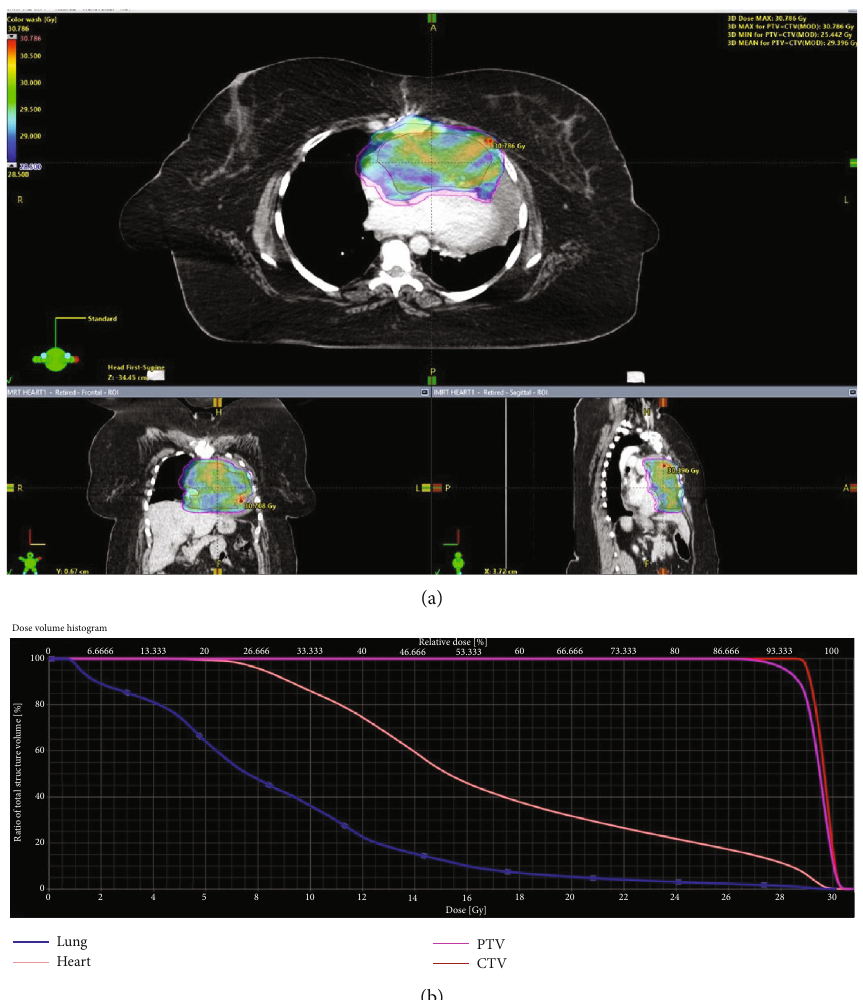
Figure 2: (a) IMRT radiation treatment plan and dose-volume histogram: clinical target volume (CTV) (red line): 95% of the dose going to 100% of the volume; planning target volume (PTV) (purple line): 95% of the dose going to 95% of the volume; heart (peach-colored line): mean heart dose of 17.2Gy; lung (blue line): V20 = 5 % and V5 = 75 % . (b) Dose-volume histogram.